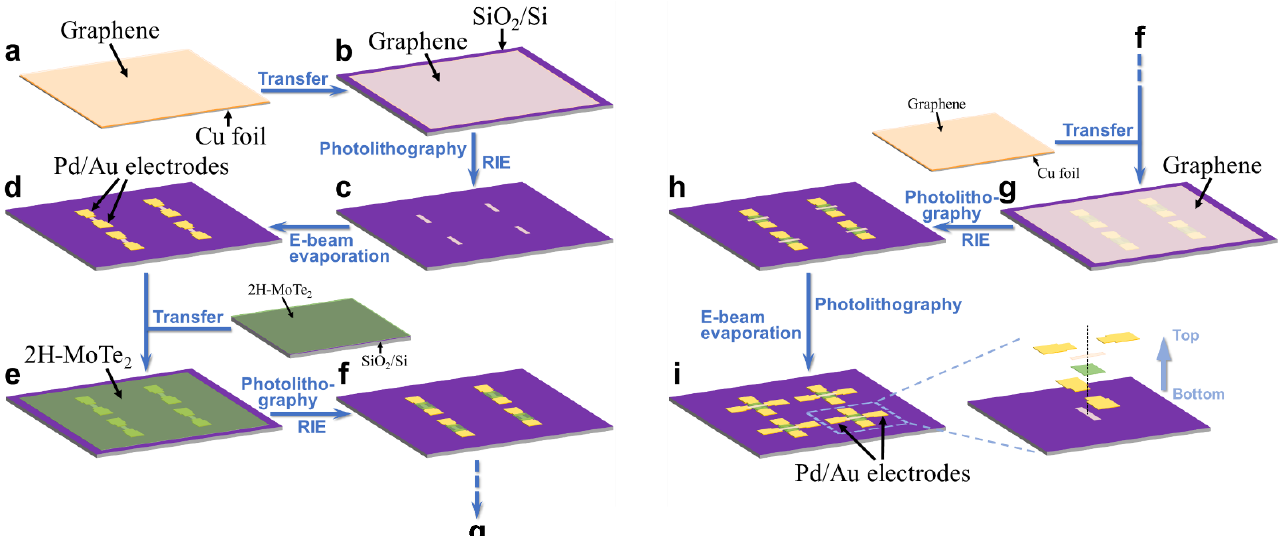
Figure 1. The fabrication procedures of the Graphene – MoTe 2 – Graphene vertical vdWs heterostructure array.